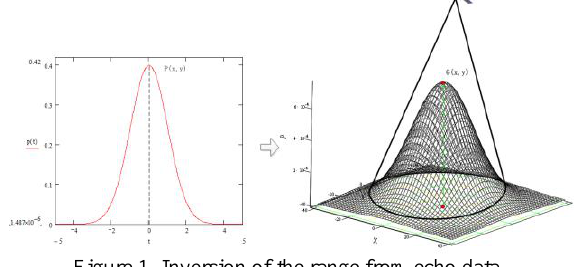
Figure 1. Inversion of the range from echo